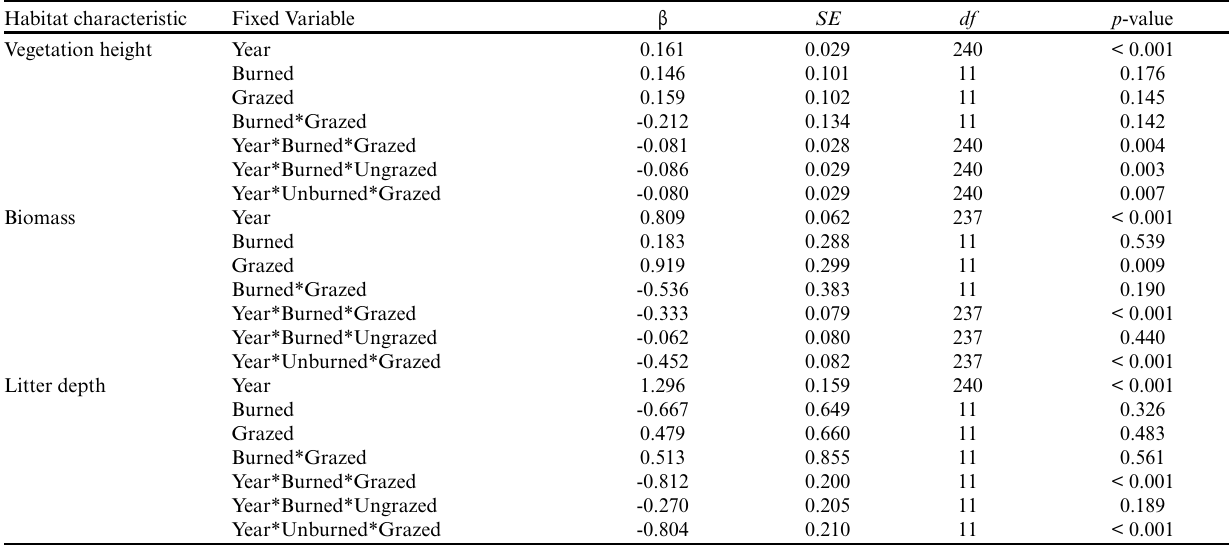
Table 3 . Interactions among year, burning, and grazing on habitat structure in Grasslands National Park of Canada from 2007 to 2010; slopes were compared against the slope for year*unburned*ungrazed when analyzing the interaction between year and treatment. Habitat